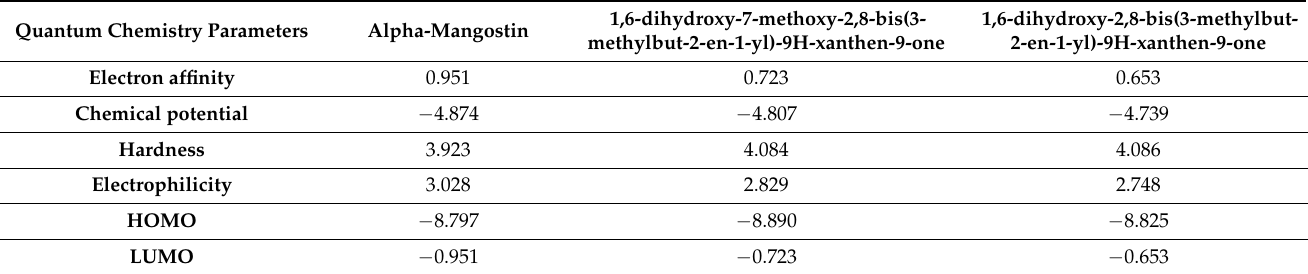
Table 3. Calculated quantum chemical parameters of alpha-mangostin and modified